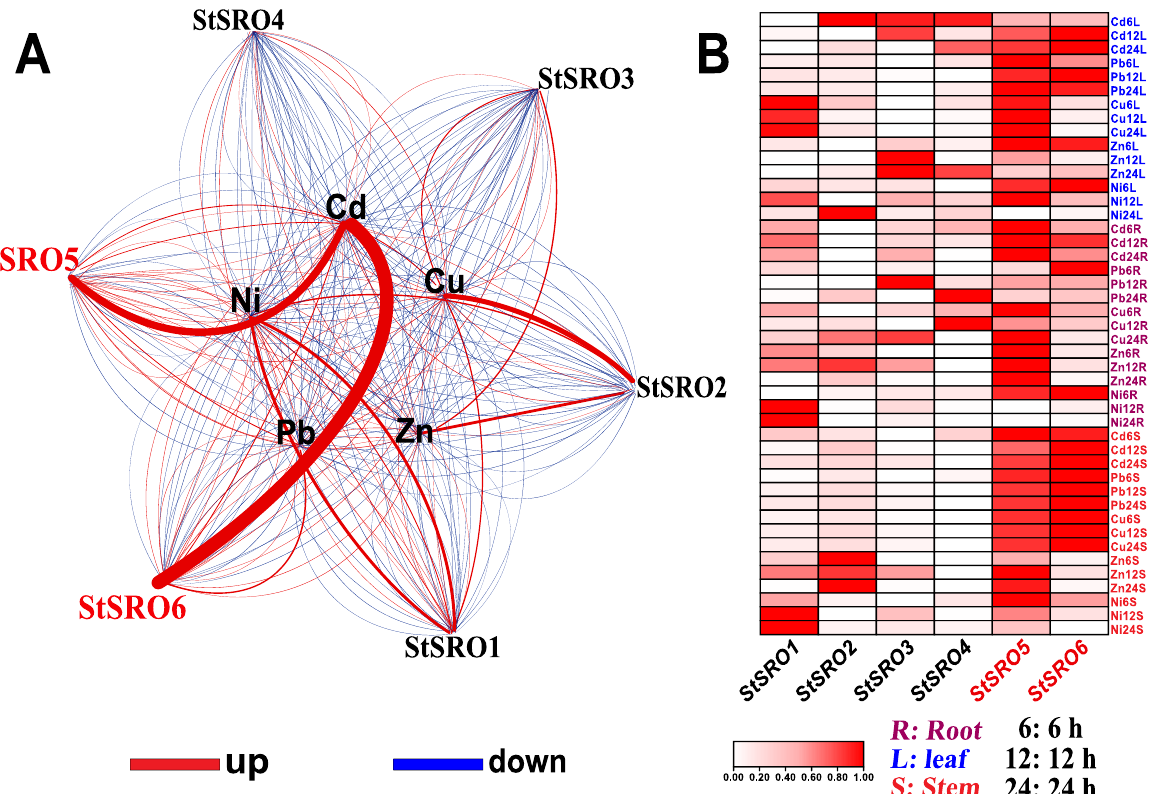
Figure 5. Co-expression network analysis of StSRO family. ( A ) Co-expression network analysis of StSROs under stress of five heavy metals. The ability of gene expression levels is shown in red (strong) and white (weak), respectively. ( B ) Expression patterns of StSROs in different tissues, changes in gene expression levels are shown in red (high) and white (low). Root, stem, and leaf are abbreviated to R, S, and T, respectively, and time (h) is denoted by 6, 12, and 24, respectively, as detailed in Supplementary Table S10.